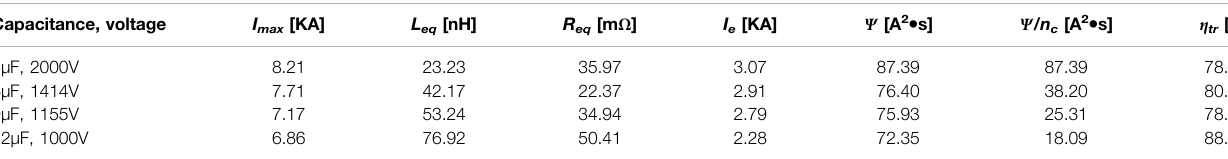
TABLE 7 | Parameters of APPT discharge circuit with different capacitance and voltage con fi gurations. Capacitance,